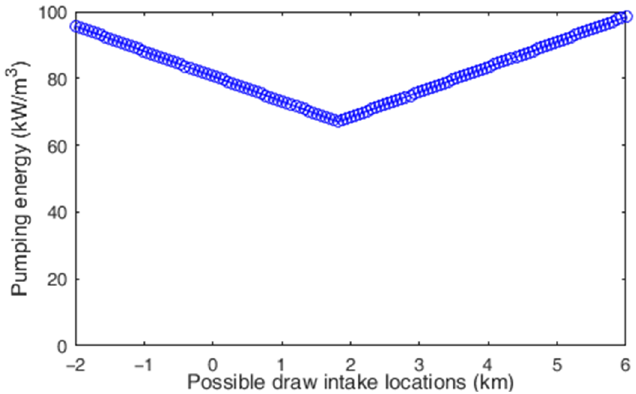
Figure 5. Pumping energy required for draw water taken from different locations for a given feed intake point at 1.8 km (horizontal axis: distance from the end of the river’s channel, with positive distances upstream).